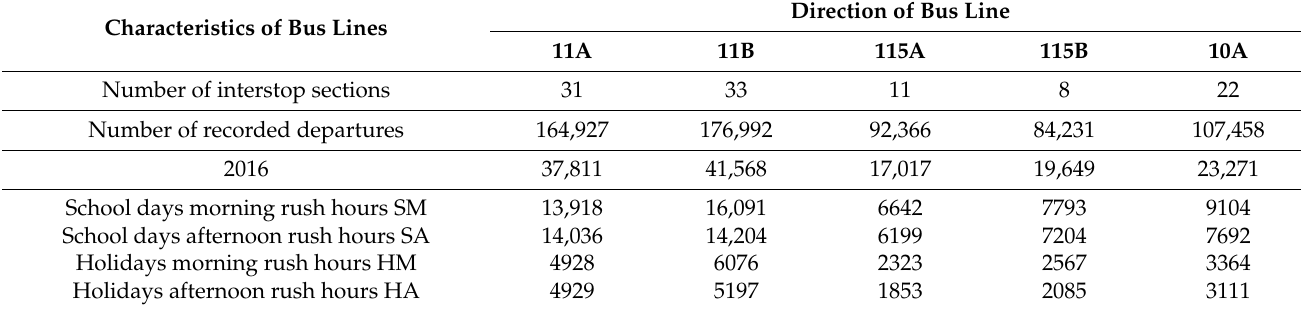
Table 1. Summary of the data sets collected for the individual directions of the lines and for each period R